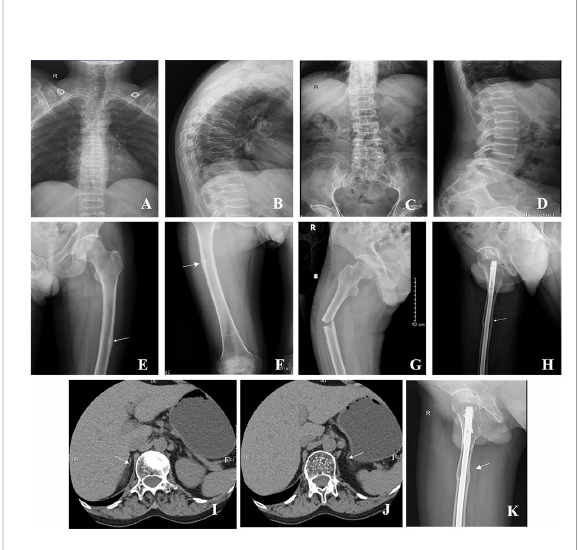
FIGURE 2 Radiographs of the patient with AHC. (A – D) Multiple vertebral compression fractures. (E, F) The white arrow shows the pseudofracture line in the left and right femurs. (G) Right femoral shaft fracture at the site of the pseudofracture line. (H) Right femoral shaft fracture after internal fi xation. (I, J) The white arrow shows that the adrenal glands on both sides were small, and the structure was unclear. (K) Right femoral shaft fracture healing in